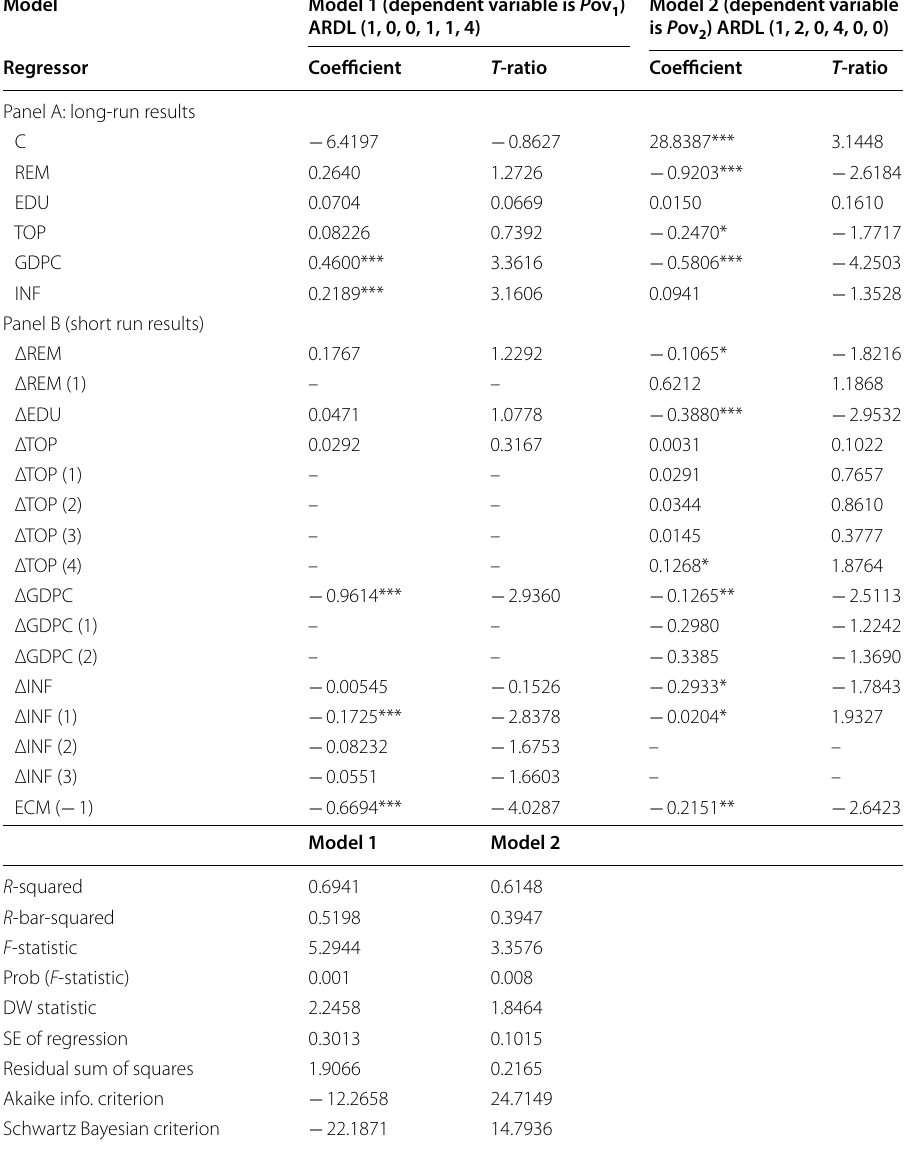
Table 3 Empirical results for Model 1 and Model 2